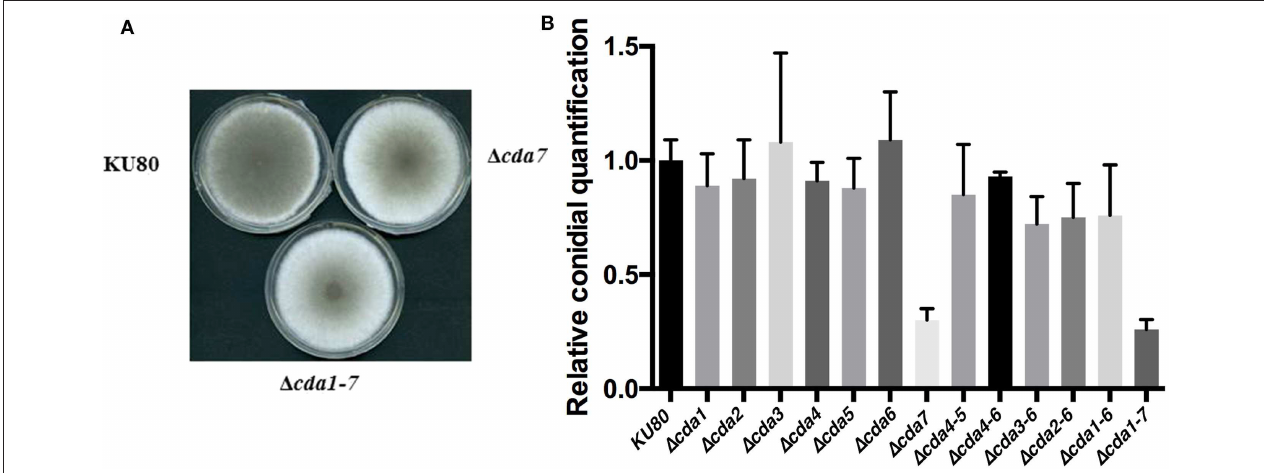
FIGURE 5 | Vegetative growth of A. fumigatus wild-type strain and 1 cda mutants on GlcNAc as sole carbon source. (A) Colonies of the KU80, 1 cda 7, and 1 cda1-7 on GlcNAc-MM; (B) Conidia quantification on GlcNAc-MM. Data are normalized to parental strain KU80.